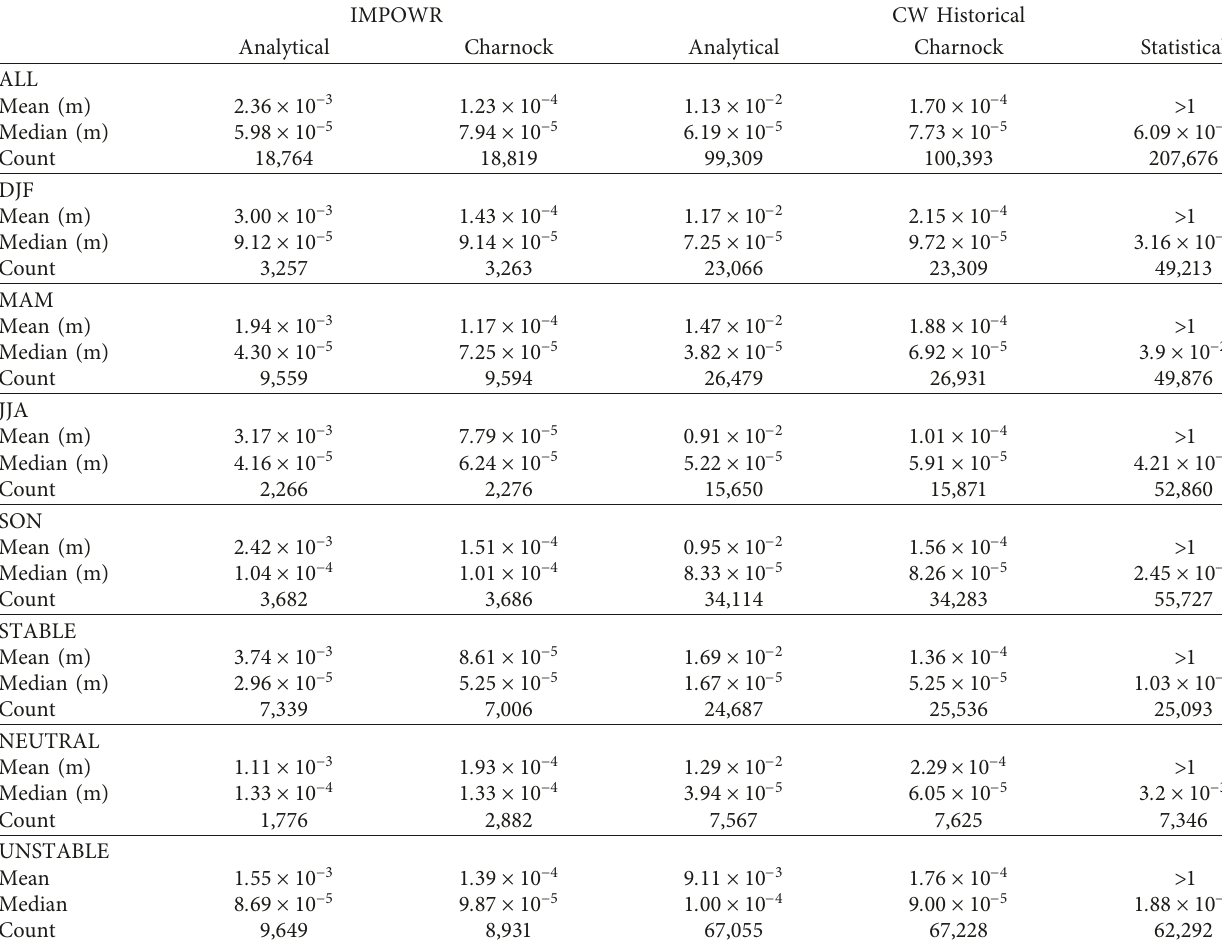
Table 4: Statistical properties of surface roughness length during the CW Historical (2003–2007) and IMPOWR (2013-2014) campaigns at the Cape Wind tower obtained with the analytical, Charnock, and statistical methods. Note that the statistical method is not intended to give realistic values of surface roughness length, which are listed here in the last column just for